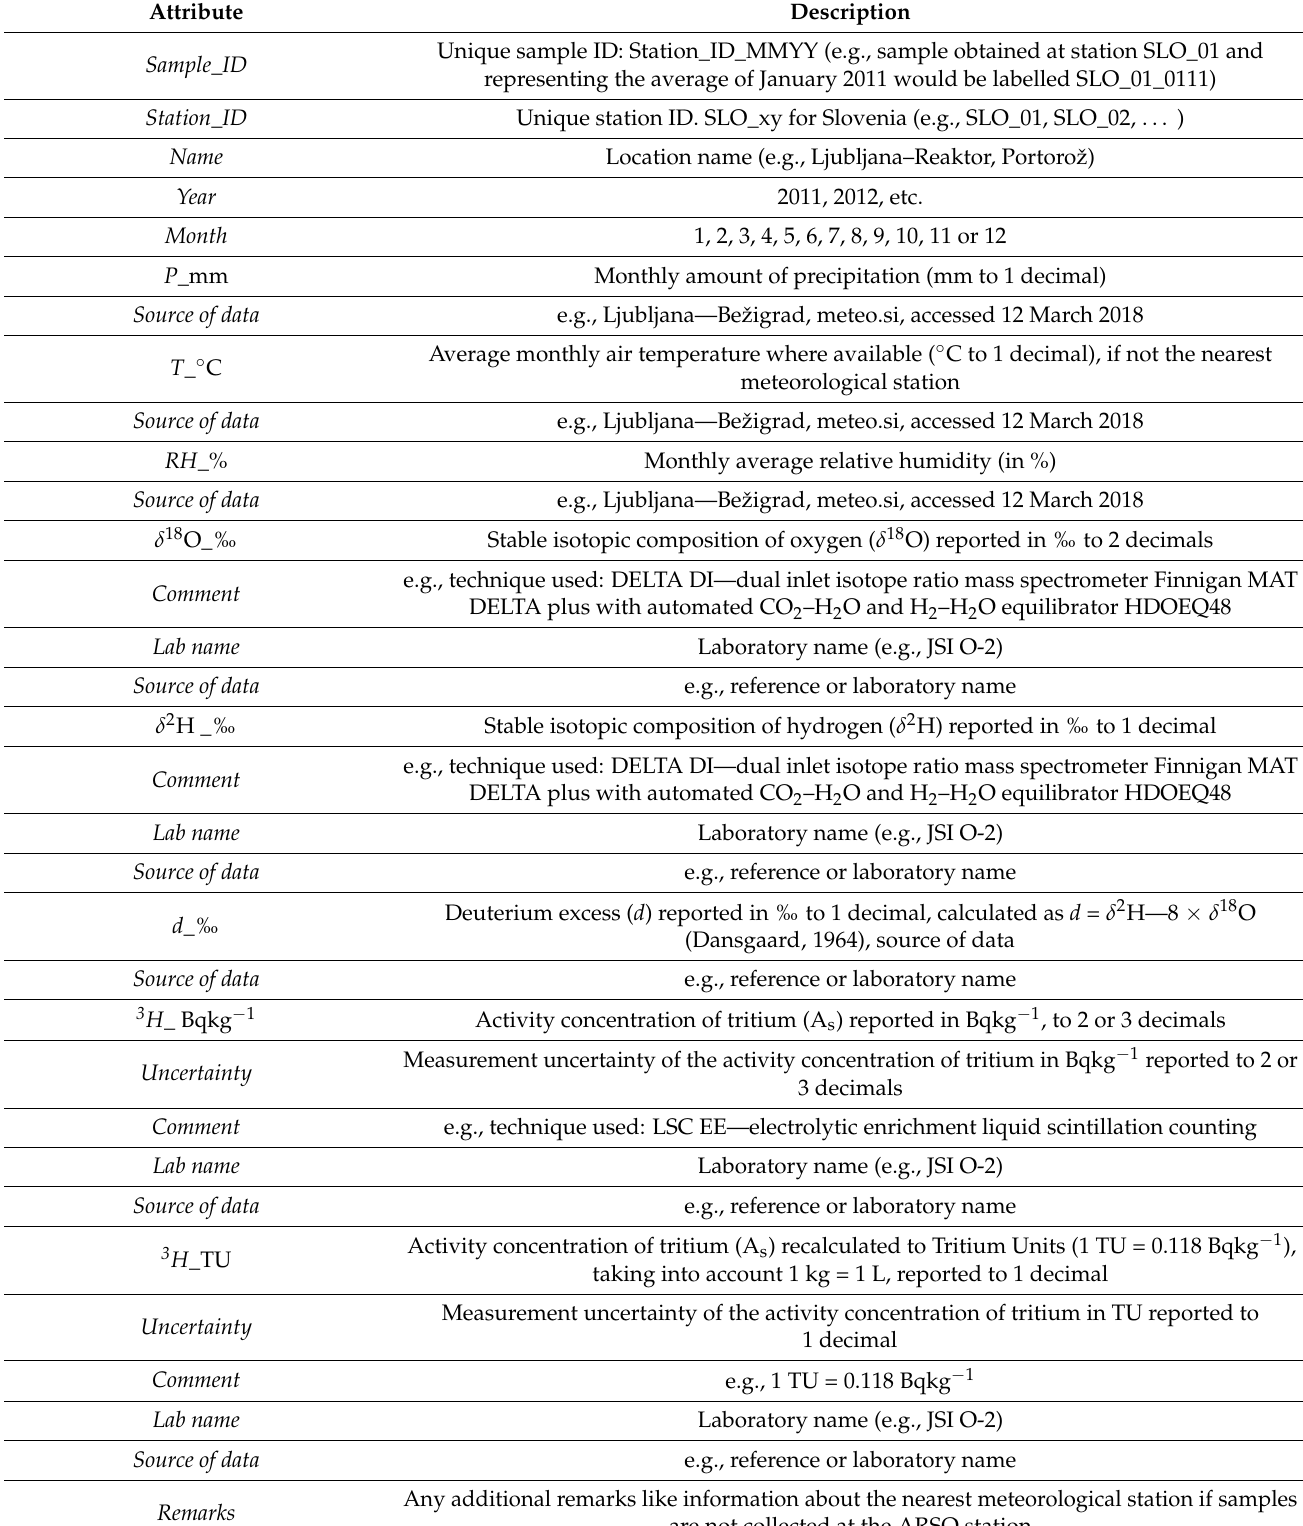
Table 2. SLONIP data